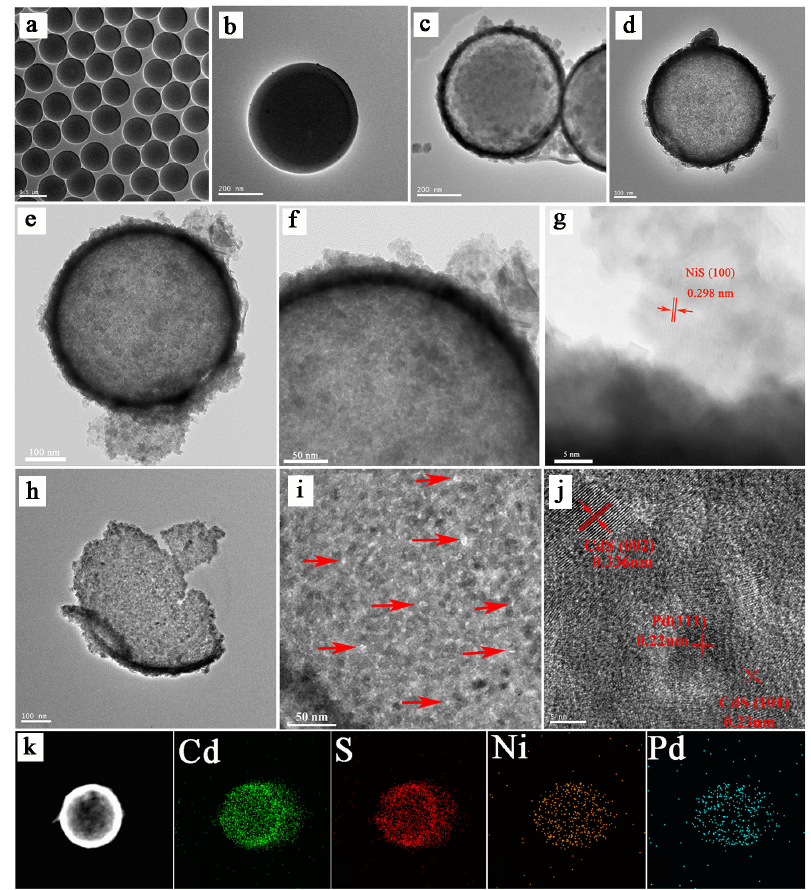
Figure 3. TEM fi gure of ( a ) SiO 2 ; ( b ) SiO 2 @Pd; ( c ) SiO 2 @Pd/CdS/NiS; ( d – f ) hollow Pd/CdS/NiS; ( g ) High-resolution TEM image of NiS; ( h ) a broken Pd/CdS/NiS hollow sphere; ( i ) a partially magnifi ed hollow sphere of broken Pd/CdS/NiS (Arrow marks the mesopore); ( j ) High-resolution TEM image of broken Pd/CdS/NiS hollow spheres; ( k ) EDX elemental mapping images of Cd, S, Ni, and Pd.